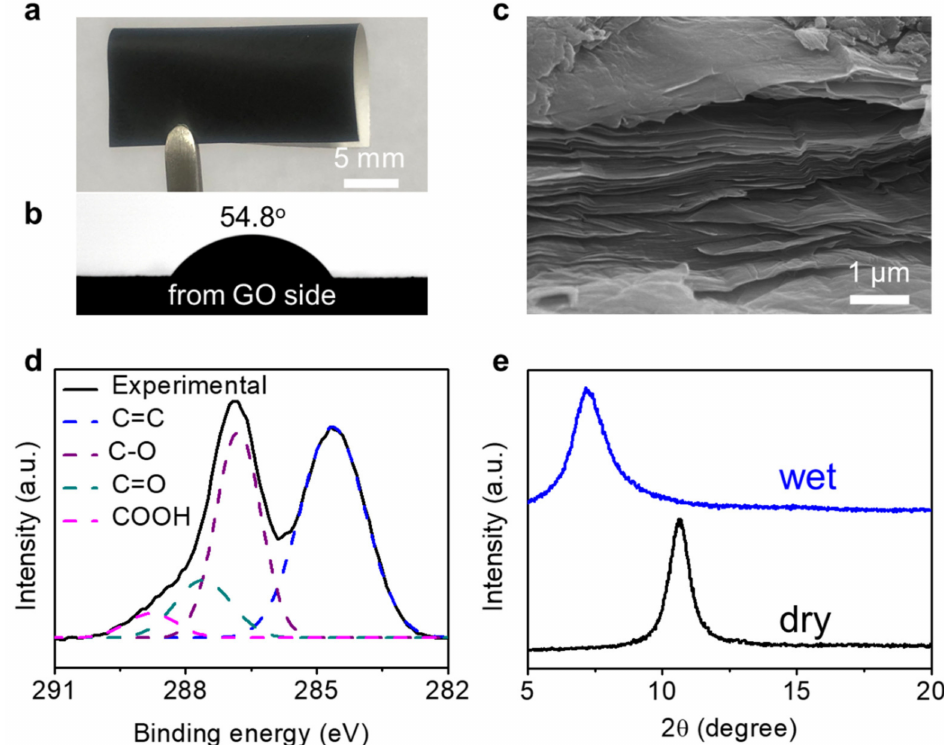
Figure 2. Characterization of the GO–CA membrane: ( a ) photograph of the flexible GO–CA hetero- geneous membrane; ( b ) surface contact angle measurement on the GO membrane (54.8 ◦ ); ( c ) SEM observation on the cross section of the GO membrane shows a lamellar structure; ( d ) XPS spectra of the GO membrane; ( e ) XRD patterns of wet and dry GO–CA heterogeneous